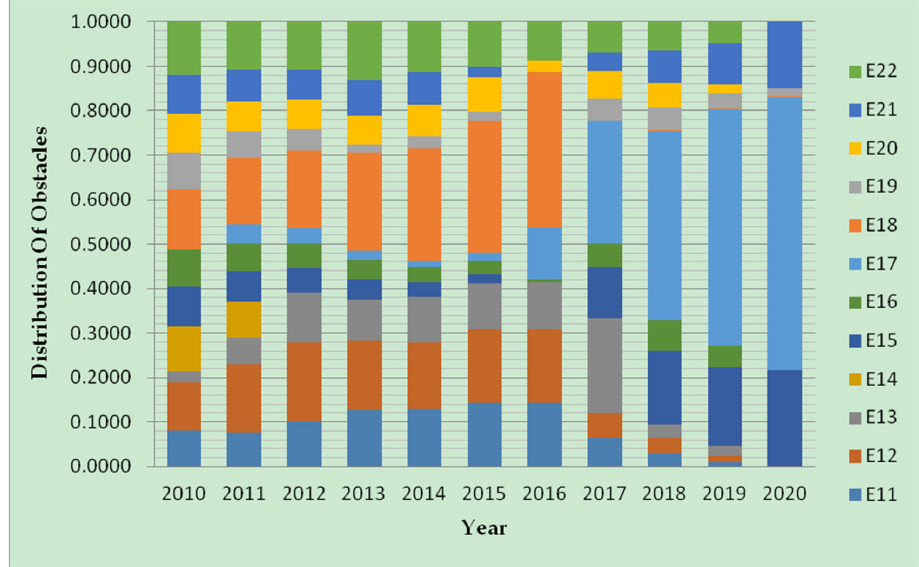
Figure 5. Distribution of obstacles to improving cultivated land-use benefits in Shiyan City.